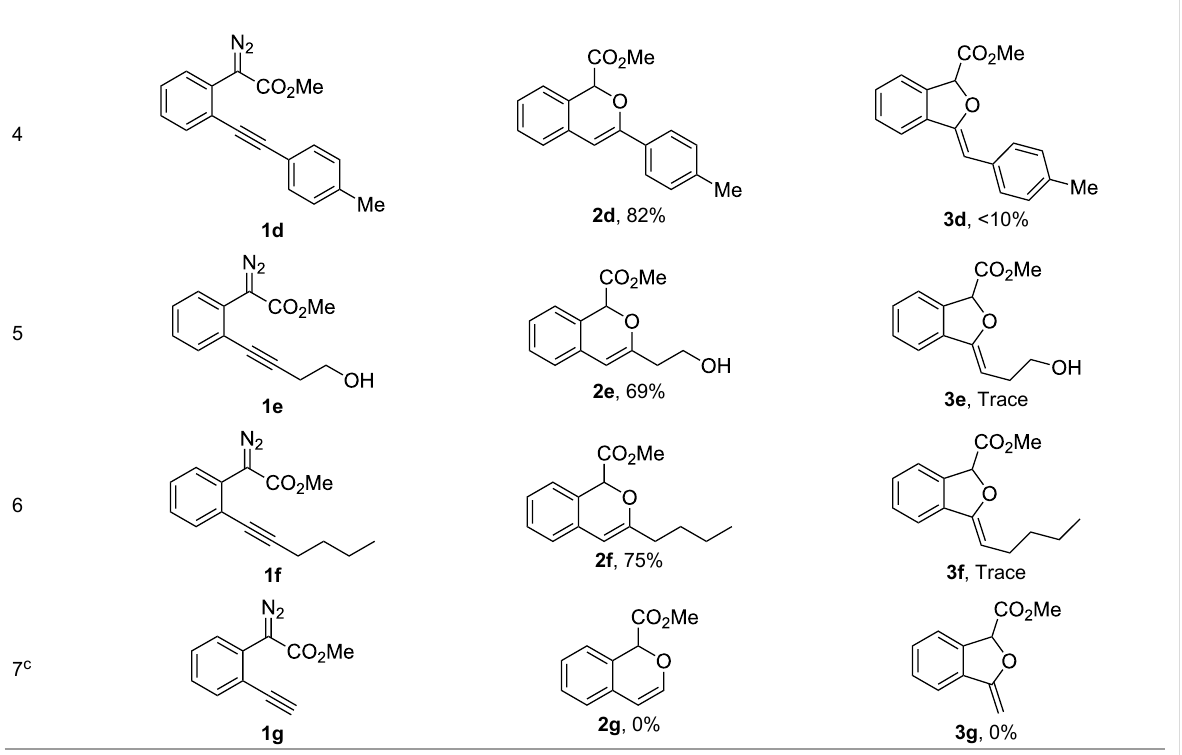
Table 2: Gold(I)-catalyzed cascade insertion/cyclization of water with various substituted phenyldiazoacetates a . (continued)